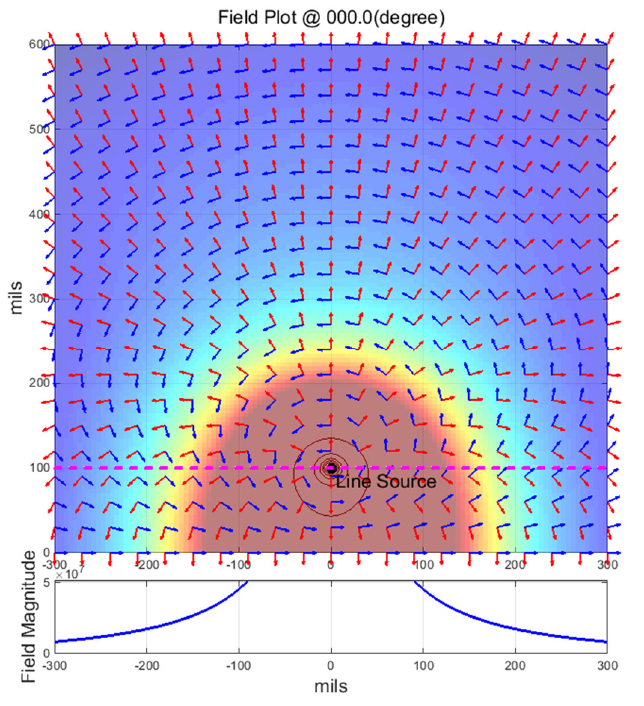
Figure 9: Field plot for 10 GHz In these field plots, the background color represents the magnitude of the field where peak magnitude is red and minimum magnitude is blue. The red arrows indicate the field (electrical field on the x-y direction of the ⃑  observation plane) and the blue arrows indicate the direction field (magnetic field on the x-y observation plane). of the ⃑  The direction of ⃑ (red arrows) and ⃑ (blue arrows) in   both figures shows that the energy is propagating in the same direction for any point on the observation plane; however, the direction of fields are not uniform for 100 GHz. This is due to time retardation of the fields. The total field is a sum of the original fields directly from the line source and the reflected field from the PEC reference plane. The total field at a